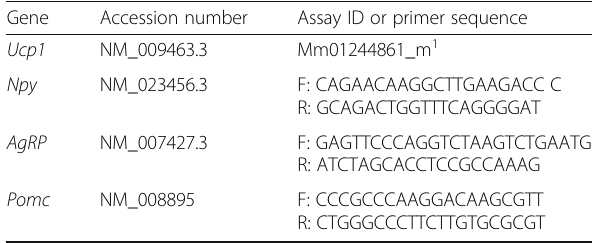
Table 1 Assay ID of the inventory primers and probes and the sequence of the self-designed primers used for